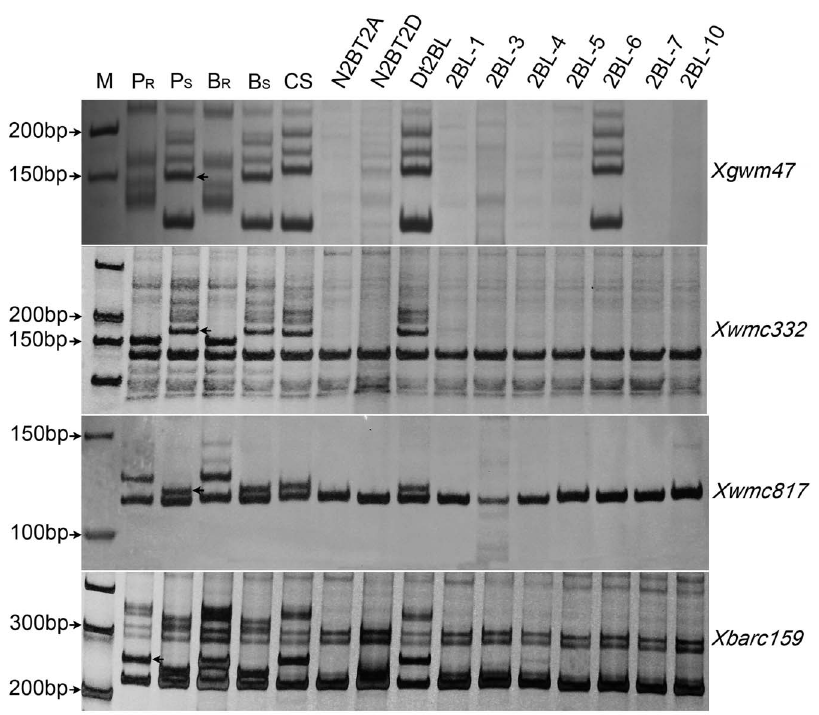
Figure 2. PCR amplification patterns of three linked microsatellite markers. M: DNA ladder; P R : CH7086; P S : CH5241; B R : resistant bulk; B S : susceptible bulk; CS: Chinese Spring; N2BT2A and N2BT2D: nullisomic- tetrasomic lines; 2BL-1, 2BL-3, 2BL-4, 2BL-5, 2BL-6, 2BL-7 and 2BL-10: homozygous deletion lines of 2BL of CS; Arrows indicate the critical